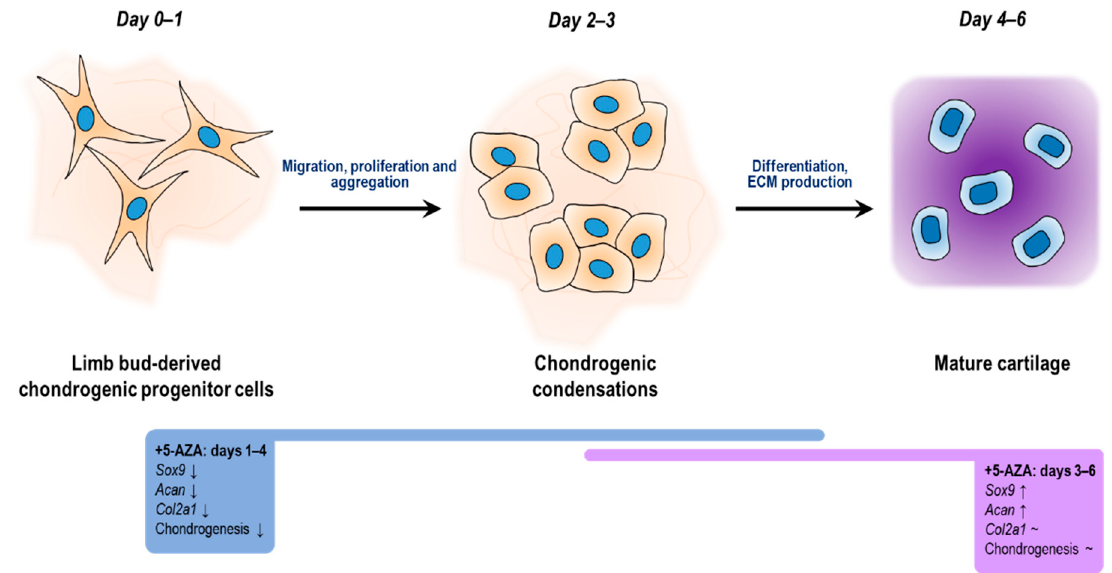
Figure 8. Diagrammatical representation of the key stages of chondrogenic differentiation of embryonic limb bud-derived micromass cultures, showing the regulation of chondrogenic genes triggered by the methylation inhibition 5-azaC on different culturing days.